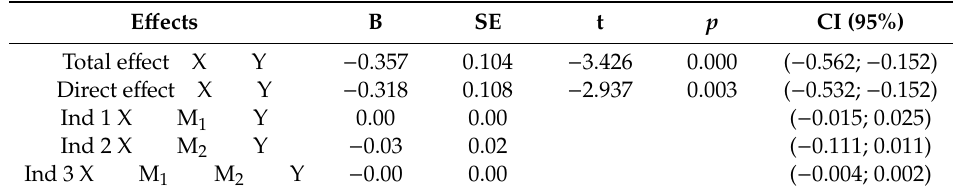
Table 3. Total, direct and indirect effect: multiple model of mediation.